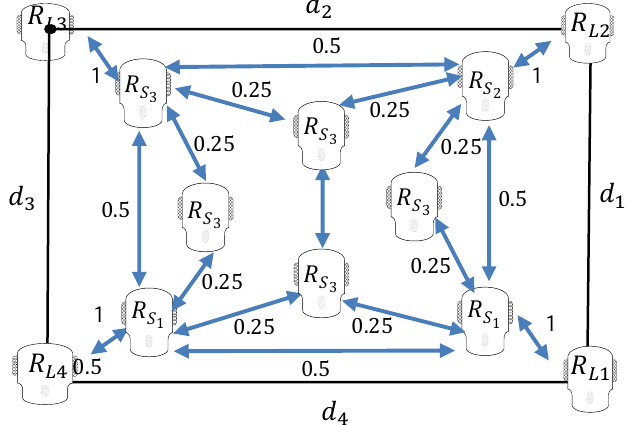
Figure 13. Formation of eight follower